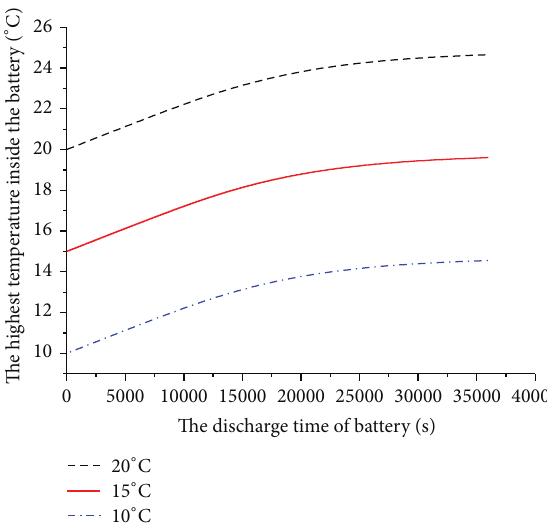
Figure 13: The battery compartment maximum temperatures over time when the speed is